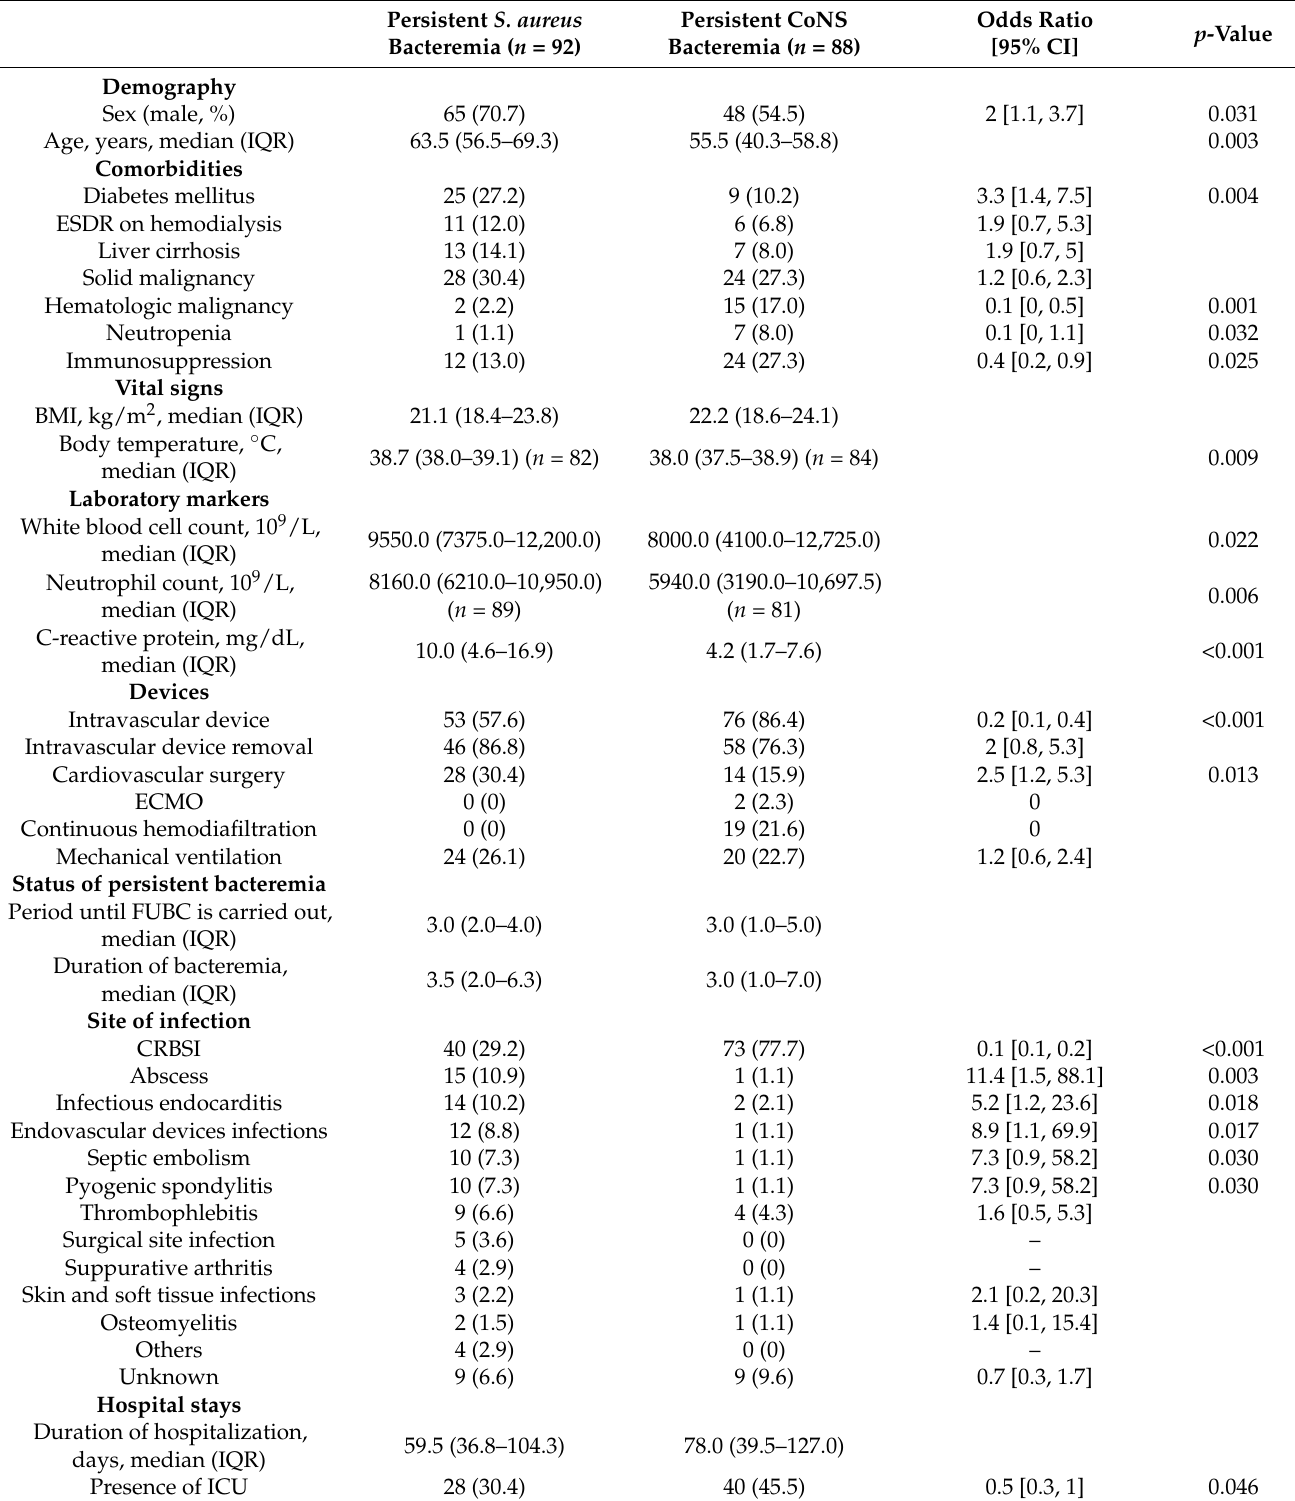
Table 1. Clinical characteristics of persistent Staphylococcus aureus bacteremia and persistent coagulase- negative Staphylococci bacteremia